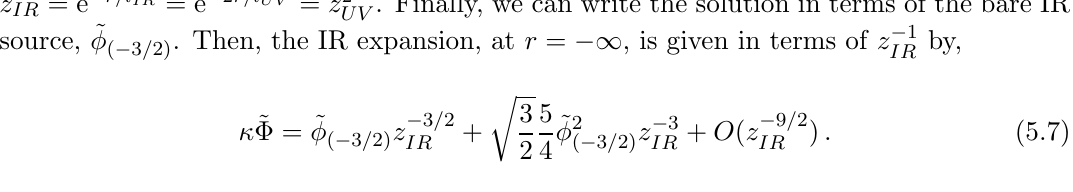
Figure 3 . Beta functions for the UV coupling in the Berg-Samtleben (cid:13)ow. The solid line repre- sents the beta function of the dimensional regularization, the dashed line ‘holographic beta func- tion’ (3.30), and the dotted line the classical beta function of the UV coupling as advocated in [49]. z = e (cid:0) r=l IR = e (cid:0) 2 r=l UV = z 2 . Finally, we can write the solution in terms of the bare IR UV